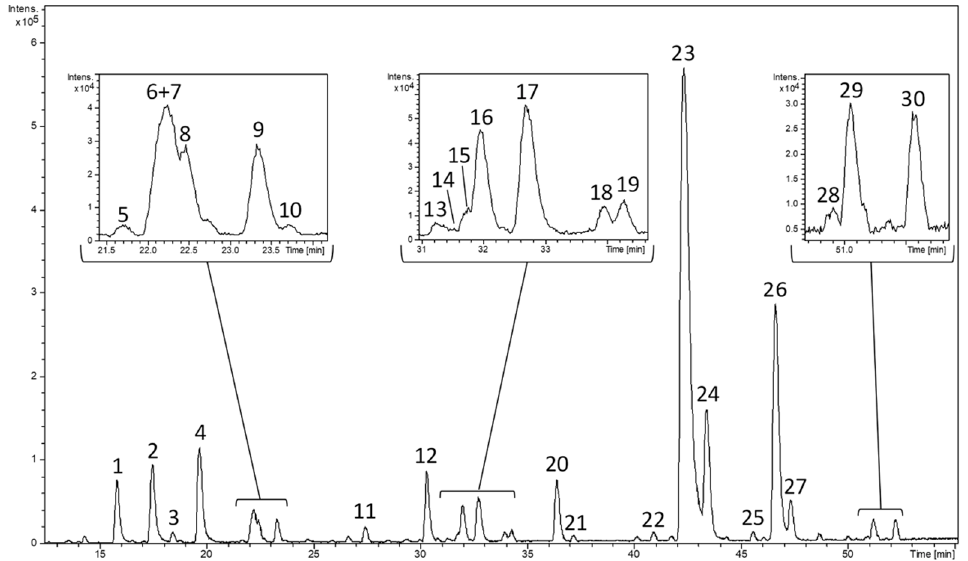
Figure 1. Base peak chromatogram (BPC) of a commercial lemon verbena extract (PLX ® 10) at 5 mg / mL obtained by high-pressure liquid chromatography (HPLC)-electrospray ionization interface (ESI)-time-of-flight (TOF)-mass spectrometry (MS) in negative ion mode. Peak numbers correspond to those of Table 1 according to the elution order.